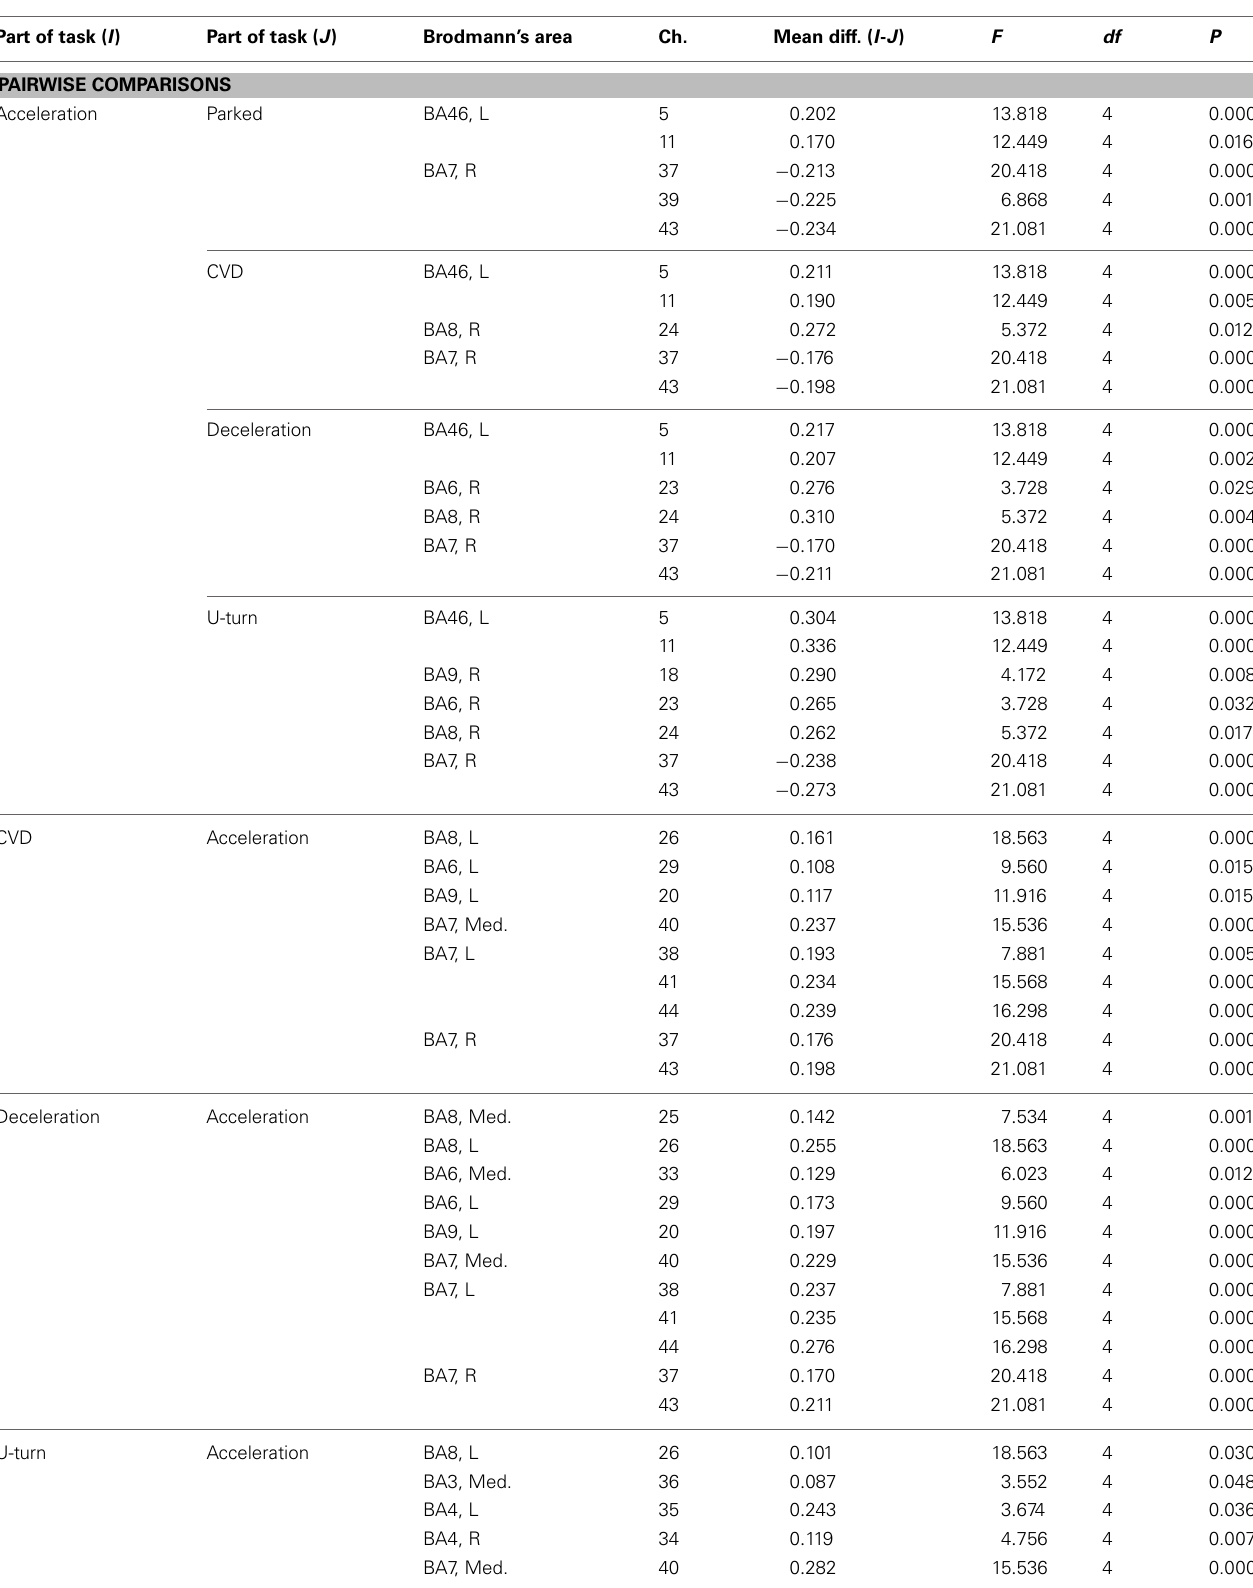
Table A3 | Channels with significant differences in (cid:2) COE between parts of the task in the daytime experiment according to a post-hoc test. Part of task ( I ) Part of task ( J ) PAIRWISE